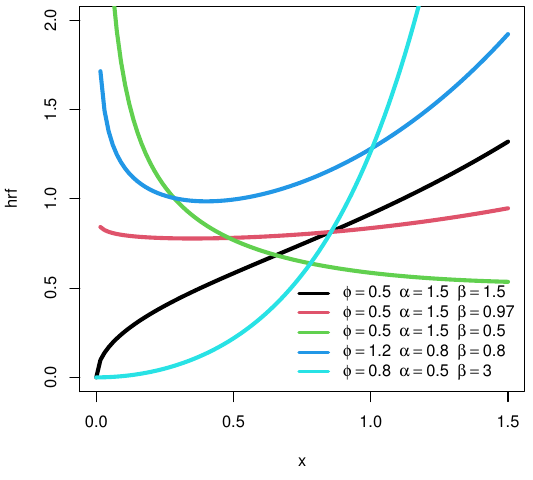
Figure 2. Panels of curves of r ( x ) for diverse values of the parameters.